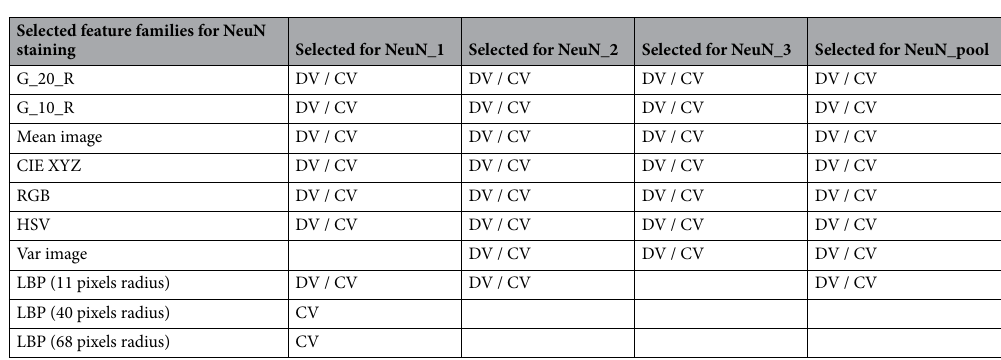
Table 3. Summary of the selected families for NeuN datasets. The feature families are sorted according to Fig. 1S, 2S, 9S and 10S. The nomenclature is presented in Material and Methods.